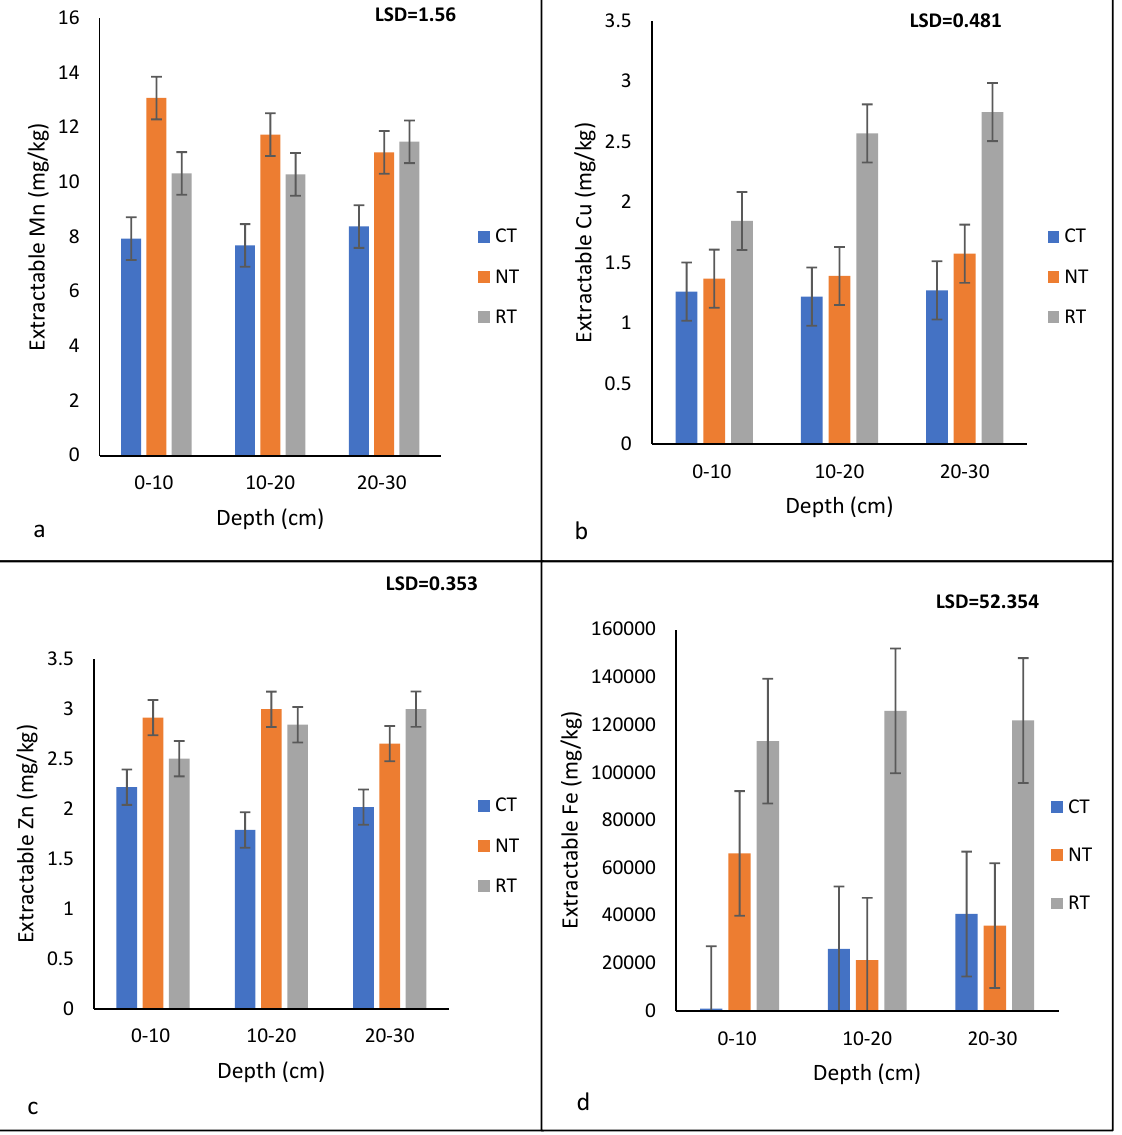
Figure 9. The concentration of extractable micronutrients [manganese (Mn) ( a ), copper (Cu) ( b ), zinc (Zn) ( c ) and iron (Fe) ( d )] at three different sampling depths (0–10, 10–20 and 20–30 cm) recorded after 17 years of trial establishment. CT = conventional tillage, RT = rotational tillage, NT = no-till. Manganese (Mn) was lower ( p < 0.05) at the 0 kg/ha N compared to 100 kg/ha and 200 kg/ha in the CT treatment (Figure 10a). The opposite was found in NT treatment where Mn decreased with an increase in N fertilizer application rate, while in RT treat- ment, no differences were found in different treatments of fertilizer. The concentration of